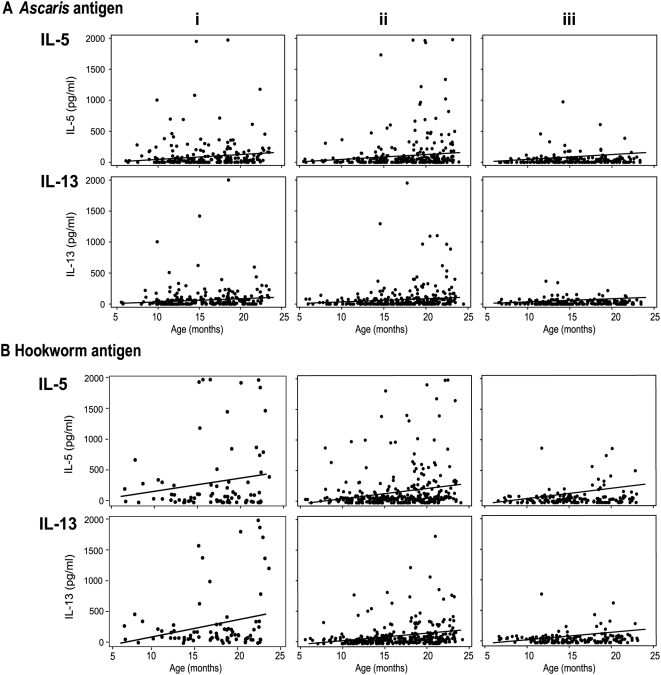
Distribution of IL-5, IL-13 responses to Ascaris and hookworm antigens with age by infection status.The lines describe the estimated linear relationship between cytokine responses and age. A) responses to Ascaris antigen by (i) all Ascaris positive infants, n = 198; Aii) all Ascaris negative/other worm positive infants, n = 273; Aiii) worm negative infants, n = 195 and in Bi) all hookworm positive infants, n = 79; Bii) all hookworm negative/other worm positive infants, n = 312; Biii) worm negative infants, n = 164.